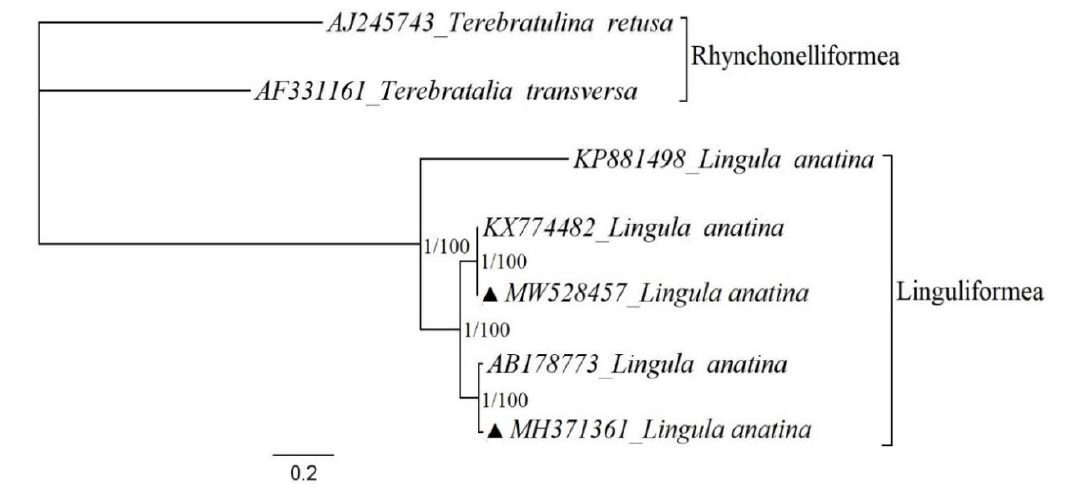
Figure 3. Phylogenetic relationships of Lingula anatina specimens from different localities based on mitochondrial protein- coding genes. The complete mitochondrial genomes for reconstruction of phylogenetic tree retrieved from GenBank and the subphylum Rhynchonelliformea records were chosen as representatives of the outgroup. The triangle shows the records sequenced for the present study. The numbers at the internodes are bootstrap values of Maximum likelihood ( right ) and posterior probability values of Bayesian inference ( left ).